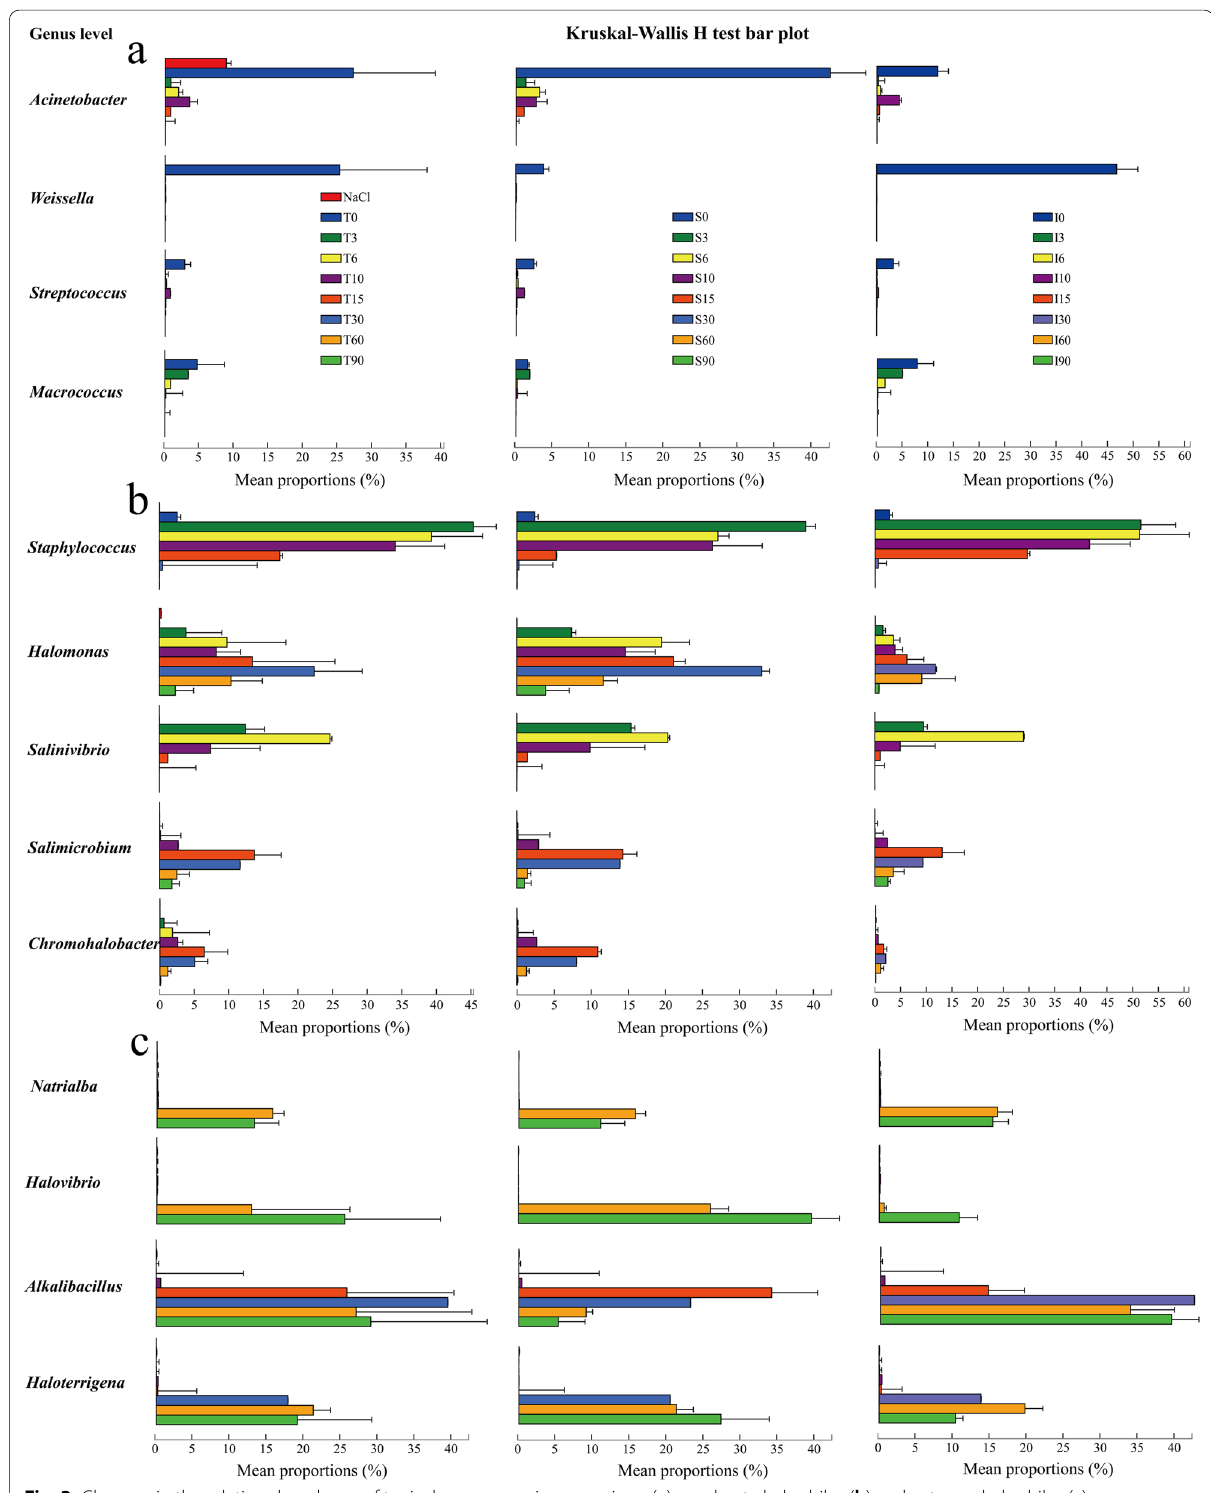
Fig. 3 Changes in the relative abundance of typical common microorganisms ( a ), moderate halophiles ( b ) and extreme halophiles ( c ) on wet-salted goatskin. NaCl indicates the negative control derived from sodium chloride particles; S indicates microbial samples derived from the animal skin surface; I represents microbial samples derived from the interior of animal skins; and the numbers indicate